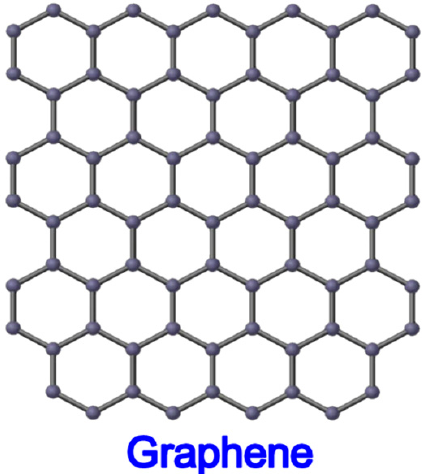
Figure 1. Graphene and graphene oxide.